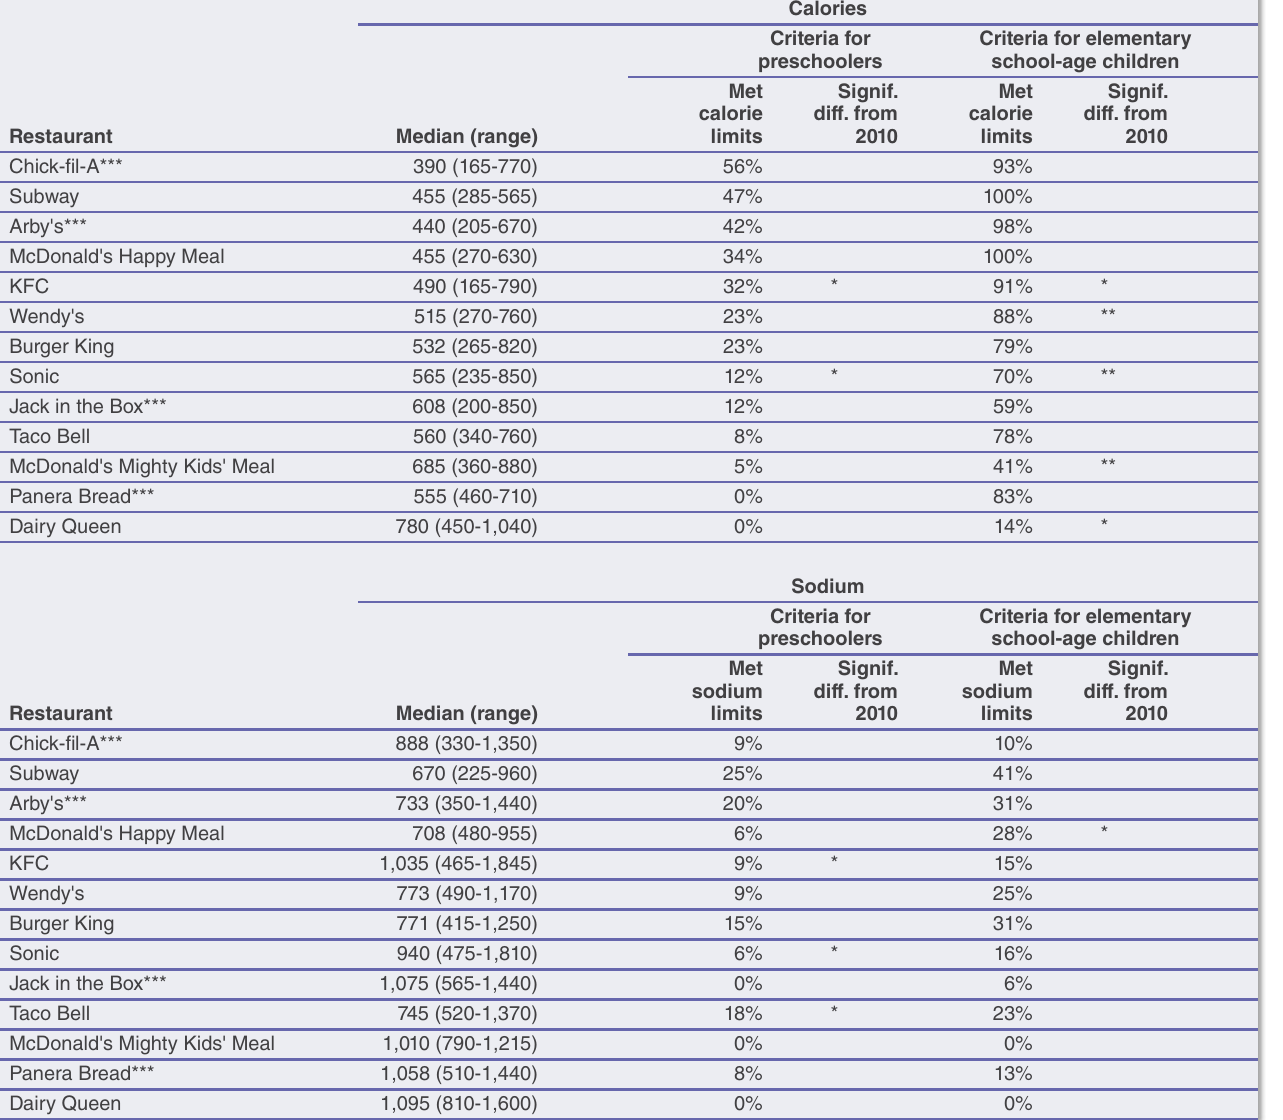
Table 6. Calorie and sodium content of kids’ meal